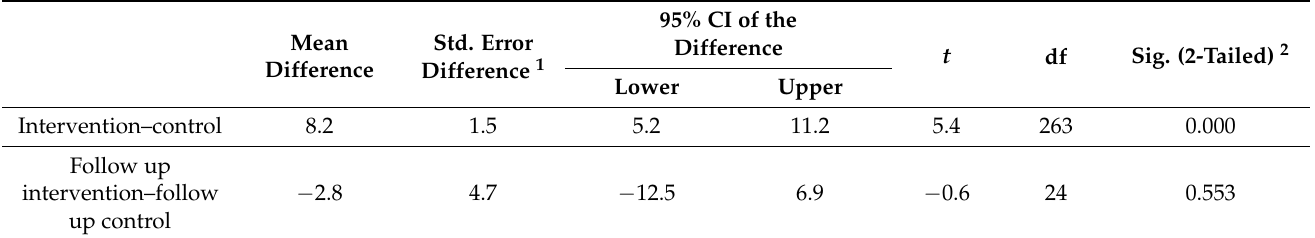
Table 3. Differences between groups—independent samples